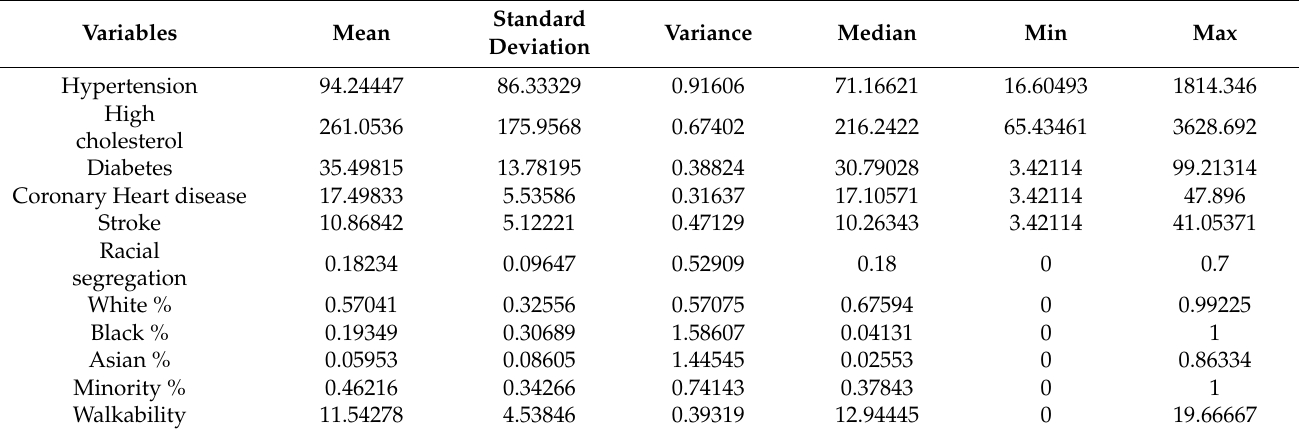
Table 2. Descriptive characteristics of health outcomes, racial segregation, and